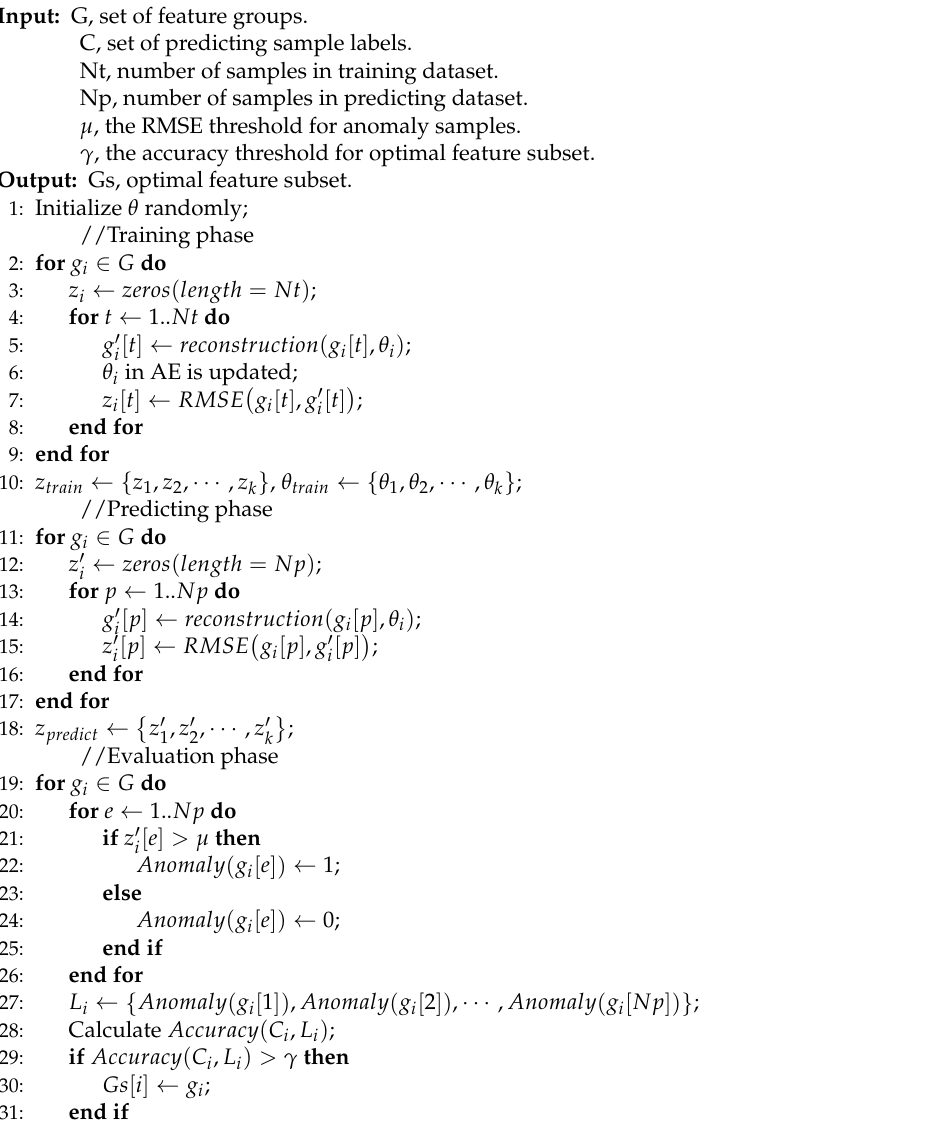
Algorithm 1 Feature subsets evaluation based on AE